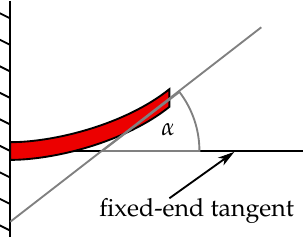
Figure 2. Drawing of the tangent angle α to the horizontal plane at the furthest point from the cantilever’s suspension.